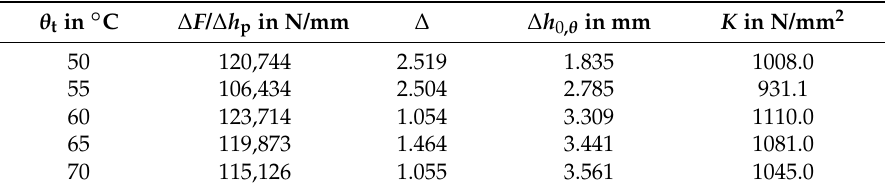
Table 3. Gradient of change of force and change of paraffin height, deviation of the gradient, change of initial absolute piston height at temperature θ .